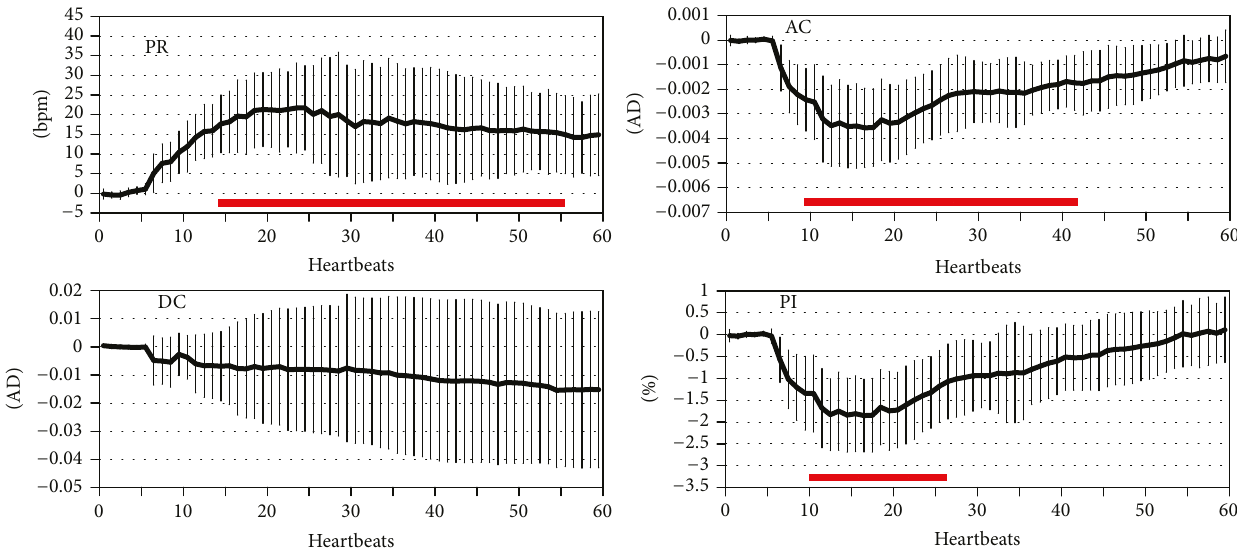
Figure 2: Change (absolute values) in pulse rate (PR) and photoplethysmogram component (AC, DC, and PI) data from baseline values. Data are mean (thick line) ± SD over 60 heartbeats. Data is illustrated for 5 heartbeats before and 55 heartbeats after the beginning of the response. The red horizontal bars illustrate values that are significantly ( 𝑝 < 0.05 ) different from baseline values. Units for AC and DC are analog-to-digital converter counts (AD).